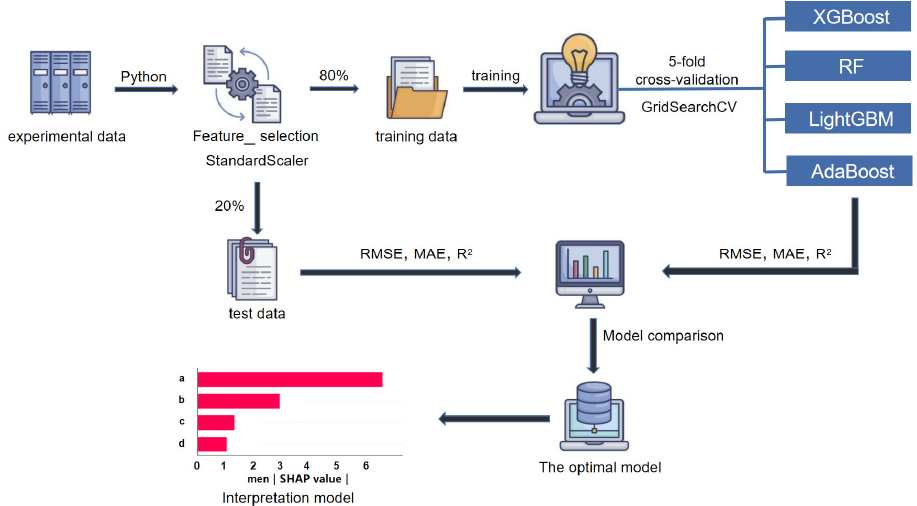
Figure 4. ML algorithm flowchart.